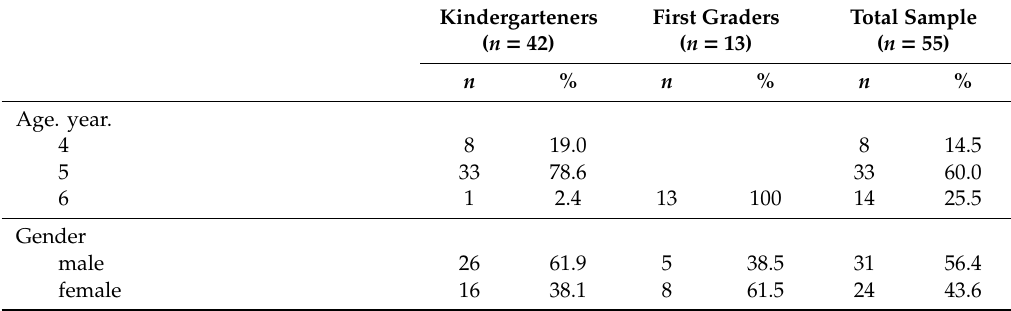
Table 1. Descriptive statistics of the demographic study variables for kindergarteners and first graders at the baseline.